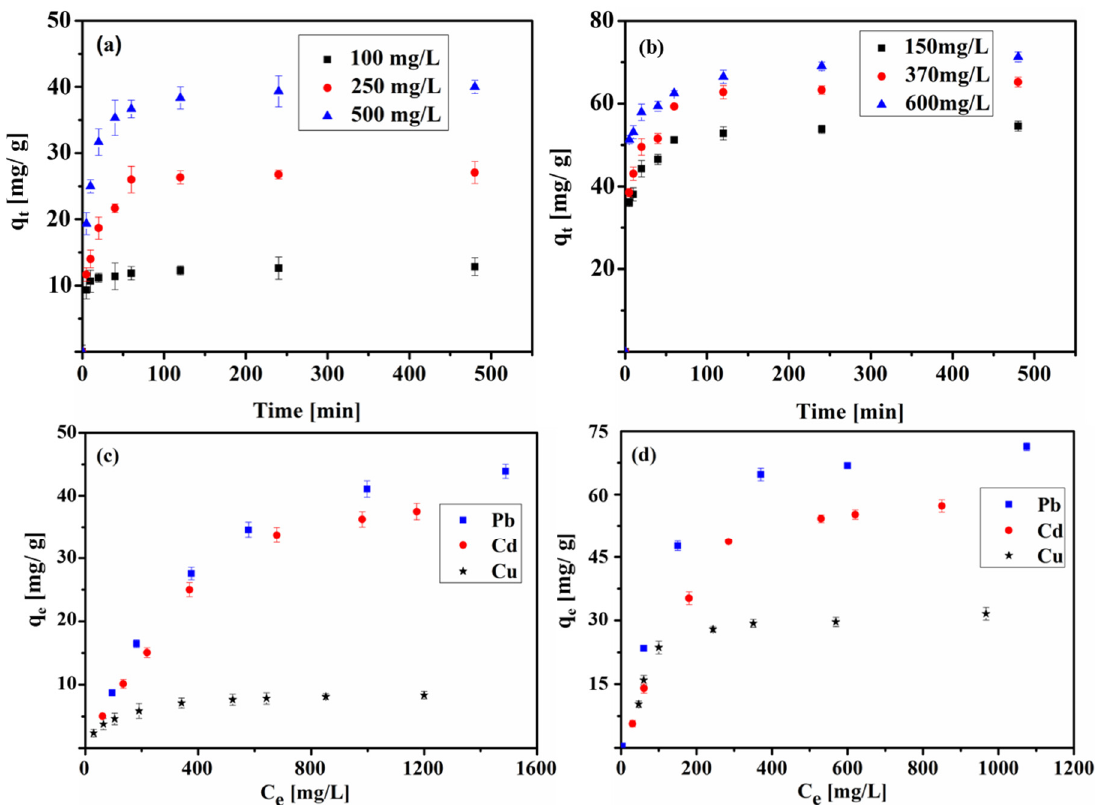
Figure 6. Kinetic analyses of Pb (II) adsorption on ( a ) BC-H 3 PO 4 as a function of contact time; ( b ) BC-ZnCl 2 as a function of contact time; Adsorption isotherms of Pd (II), Cd (II) and Cu (II) on ( c ) BC-H 3 PO 4 and ( d ) BC-ZnCl 2 . Table 2. Kinetic fitting parameters of pseudo-first-order (PFO), pseudo-second-order (PSO) and intra-particle di ff usion (IP) models for BC-H 3 PO 4 and BC-ZnCl 2 removal of Pb (II).